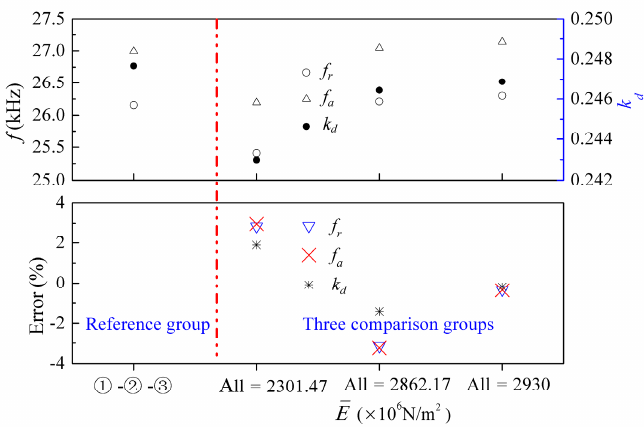
Figure 8. Influence of Young’s modulus of the epoxy layers on the electromechanical characteristics of the transducer. Error = (Reference group − Comparison group)/Reference group.